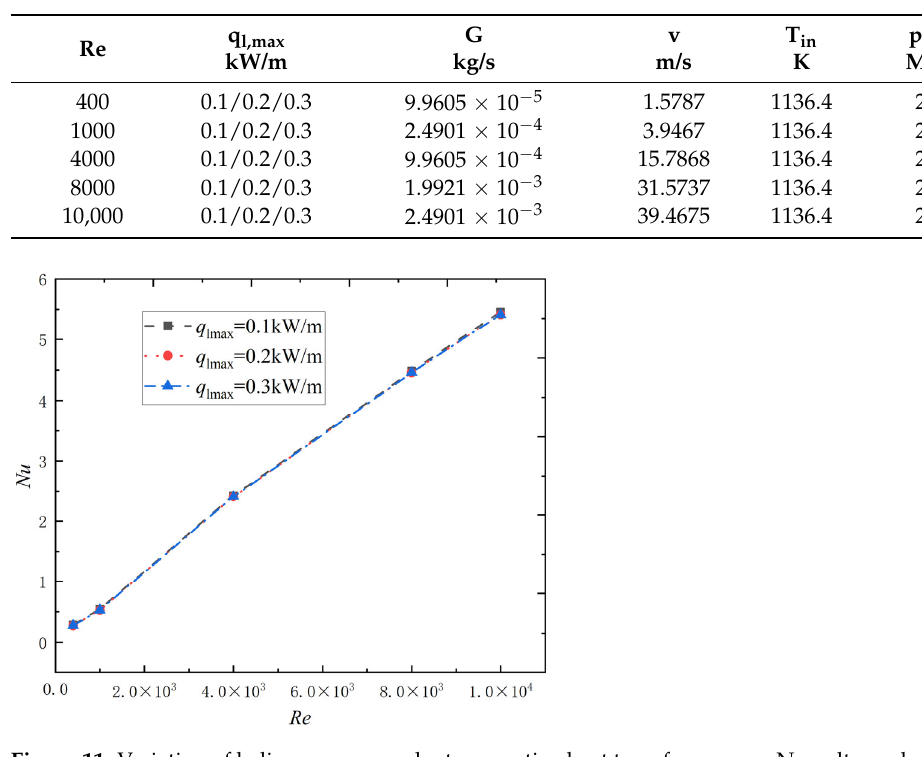
Figure 12. Variation of convective heat transfer coefficient of the helium–xenon gas mixture in the channel with the fuel rod’s heating power distribution [9]. 2.3. Applicability Verification of Existing Nusselt Number Correlations Zhou et al. [14,21] studied the applicability of some existing Nusselt number correlations by comparing the experimental values with the prediction data of each correlation formula and then analyzing their prediction accuracy. The relevant correlations involved are shown in Table 6.